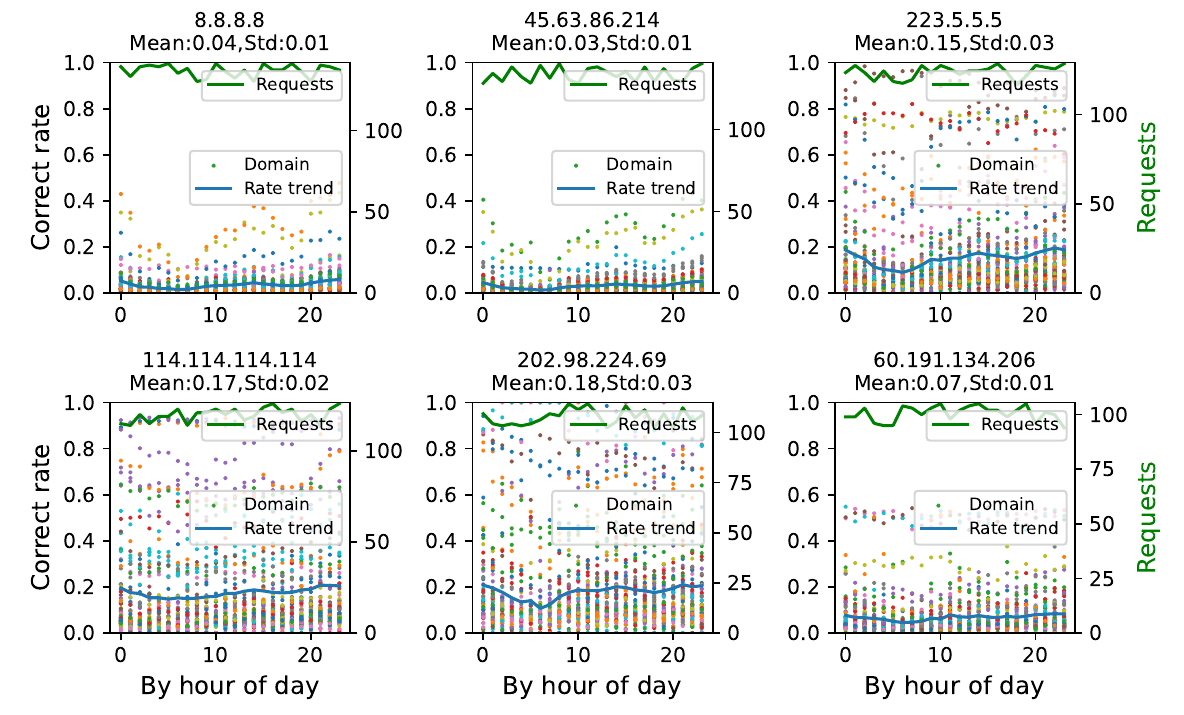
Figure 11. Correct response rate of DNS resolvers answering domain from 00:00 to